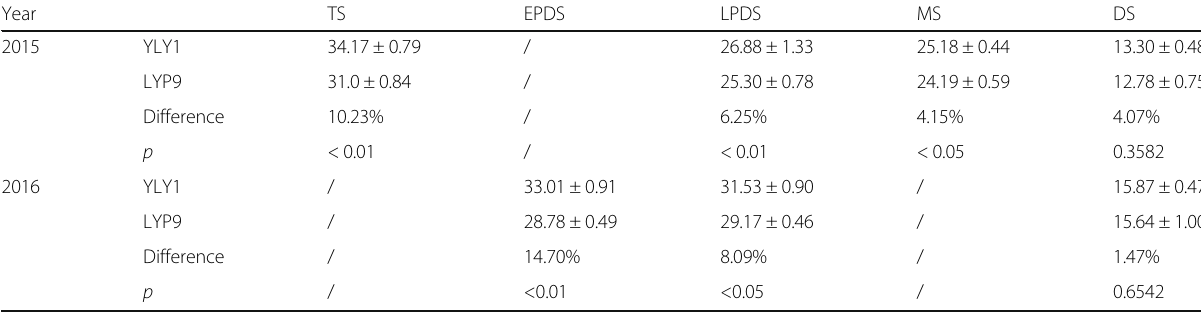
Table 3 Maximum light saturated rate of leaf photosynthesis (A sat ) of uppermost or flag leaves were measured with a portable photosynthesis system LI-6400XT, and the photosynthetic photon flux density (PPFD) were 1600 μ mol m − 2 s − 1 at different growth stages for cv. YLY1 and LYP9. The p values are probability of two-sided t-test. n = 10. A sat ( μ mol m − 2 s − 1 ) (mean ± SD)